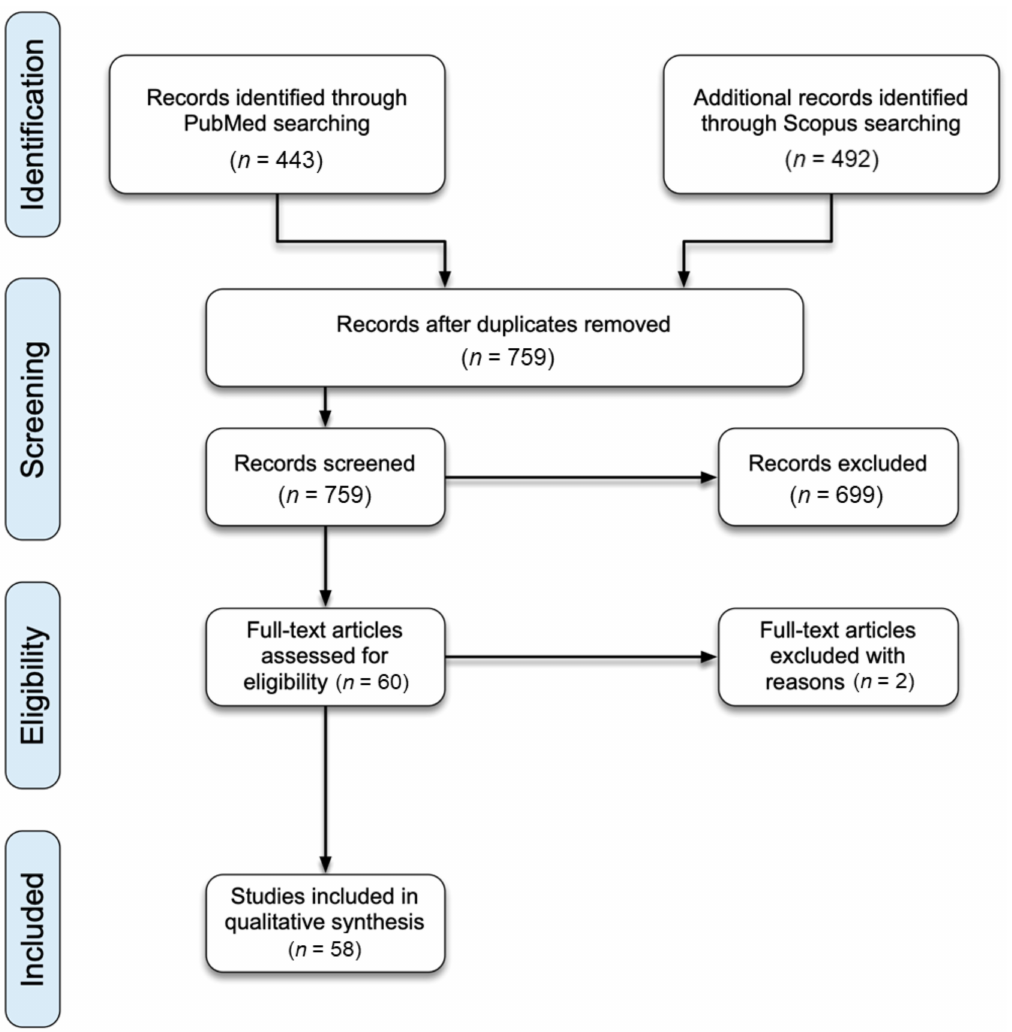
Figure 1. PRISMA diagram for systematic literature